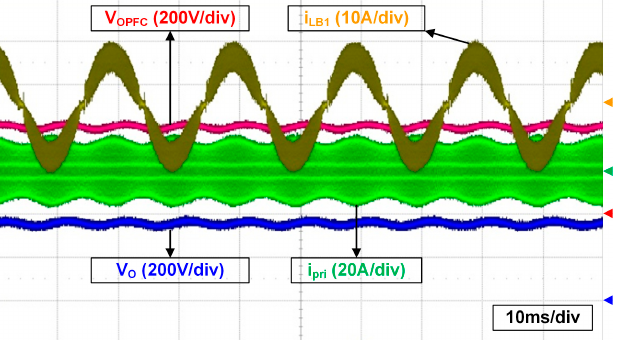
Figure 11. Captured waveforms of the prototype at 100% load condition. The modified PFC ON/OFF control is inactive above 50% load condition.